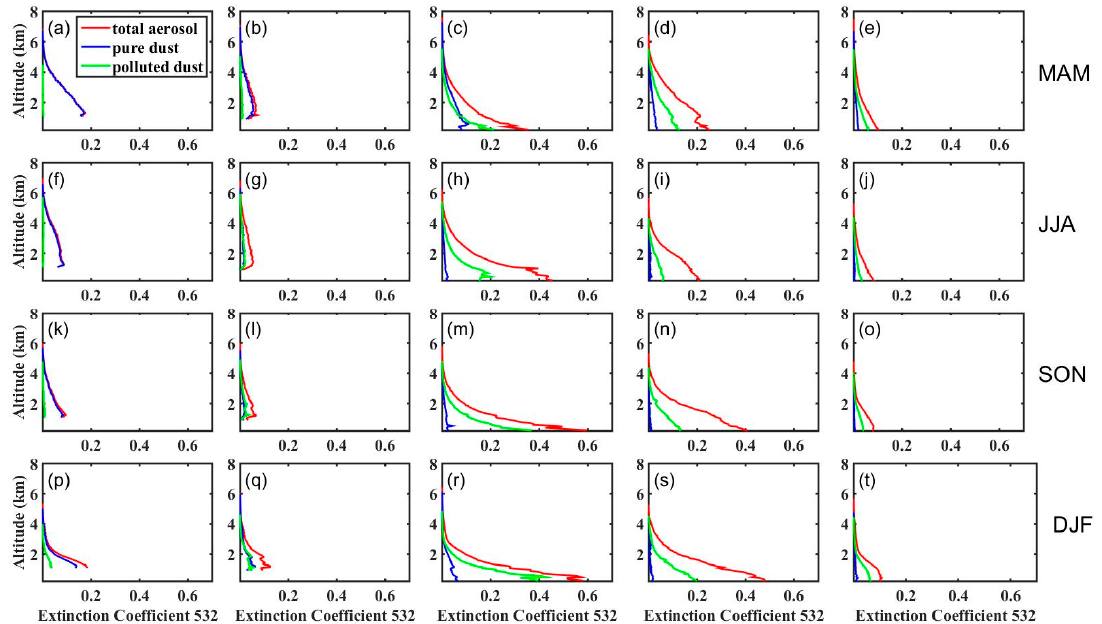
Figure 6. Profiles of the seasonal average aerosol extinction coefficient (km − 1 ) derived from CALIPSO observations over 1. The Taklimakan Desert ( a , f , k , p ), 2. The Gobi Desert ( b , g , l , q ), 3. Northern China ( c , h , m , r ), 4. Southern China ( d , i , n , s ) and 5. Korea-Japan ( e , j , o , t ).